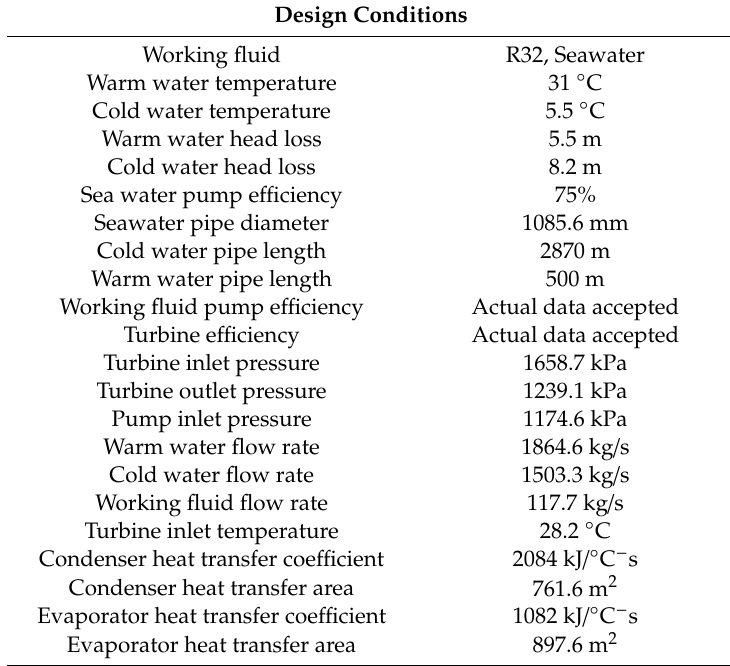
Table 1. Specifications for the closed-cycle